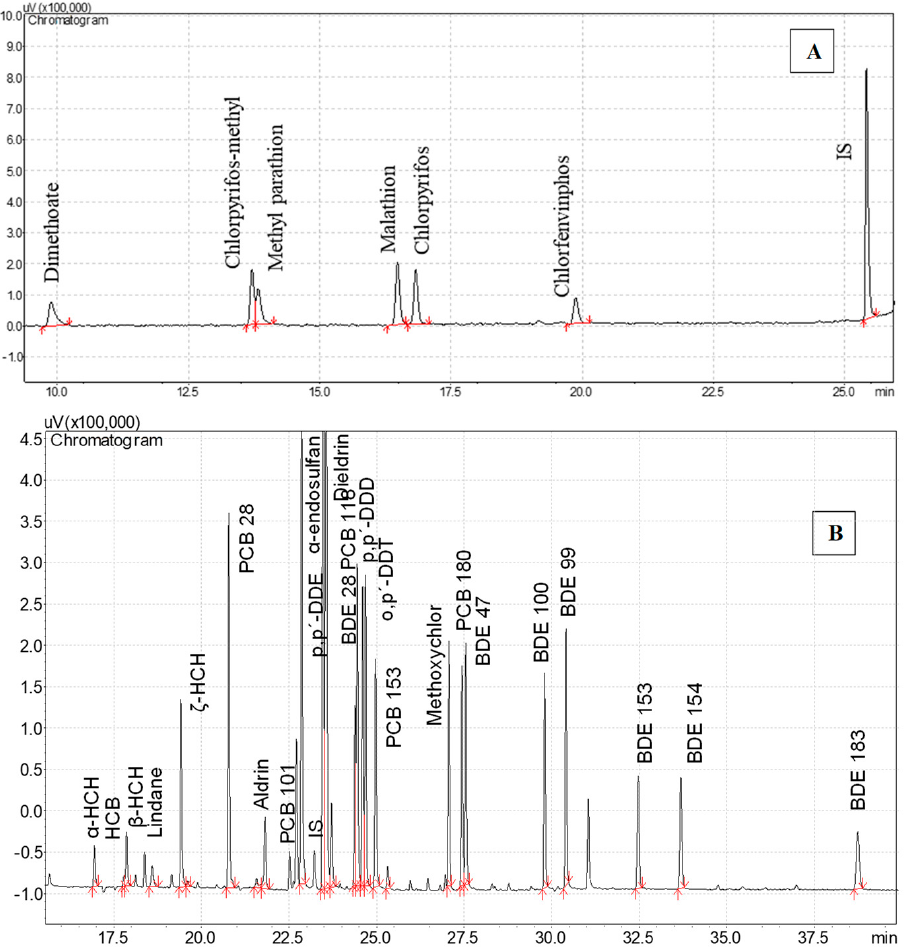
Figure 2. ( A ) Chromatogram of the injection by GC-FPD of a standard mixture of 7 organophosphorus pesticides at 7.5 µg kg − 1 . ( B ) Chromatogram of the injection by GC-ECD of a standard mixture of 23 halogenated organic compounds (5 PCB, 7 BFR and 12 OCP) 7.5 µg kg − 1 .